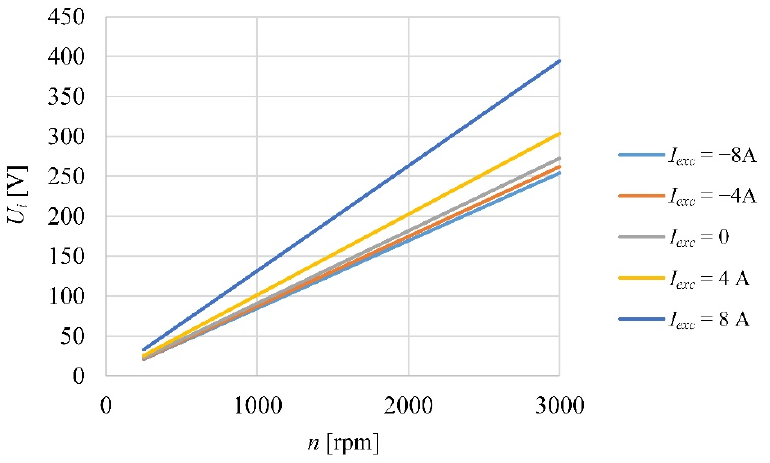
Figure 8. RMS value of back-EMF vs. rotational speed for different values of DC coil current.